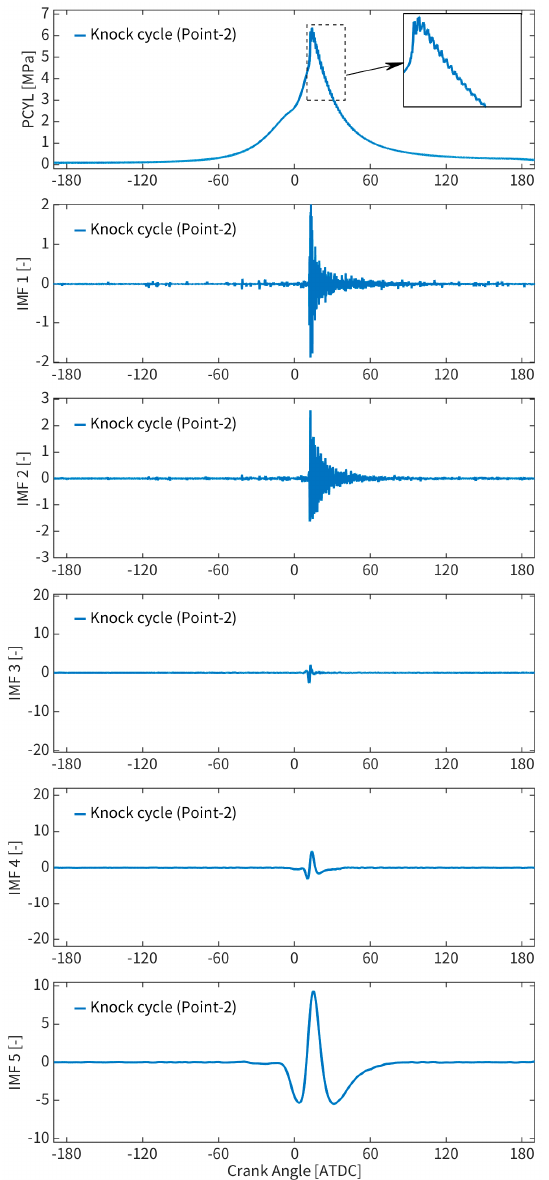
Figure 9. KI_AVL with respect to IKI of Point 6.